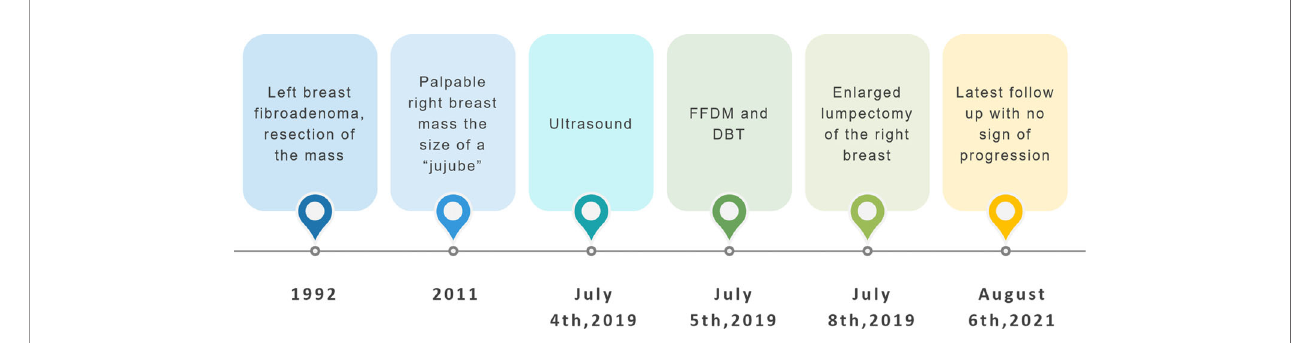
FIGURE 1 | Timeline of the relevant data of this case.